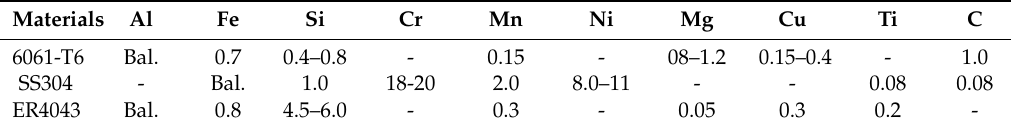
Table 1. Nominal chemical compositions of base metal and filler